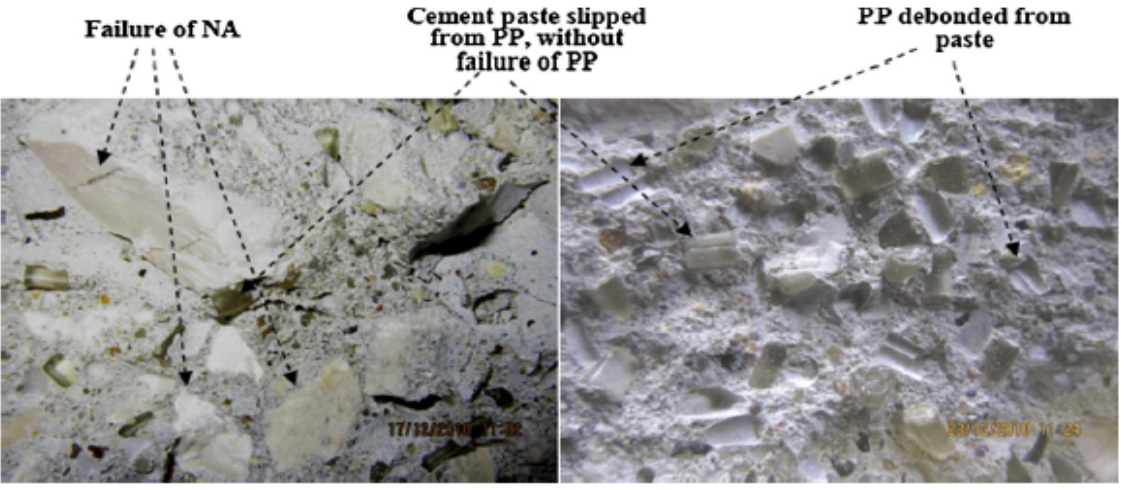
Figure 7. Poor Bond between Plastic and Cement Paste